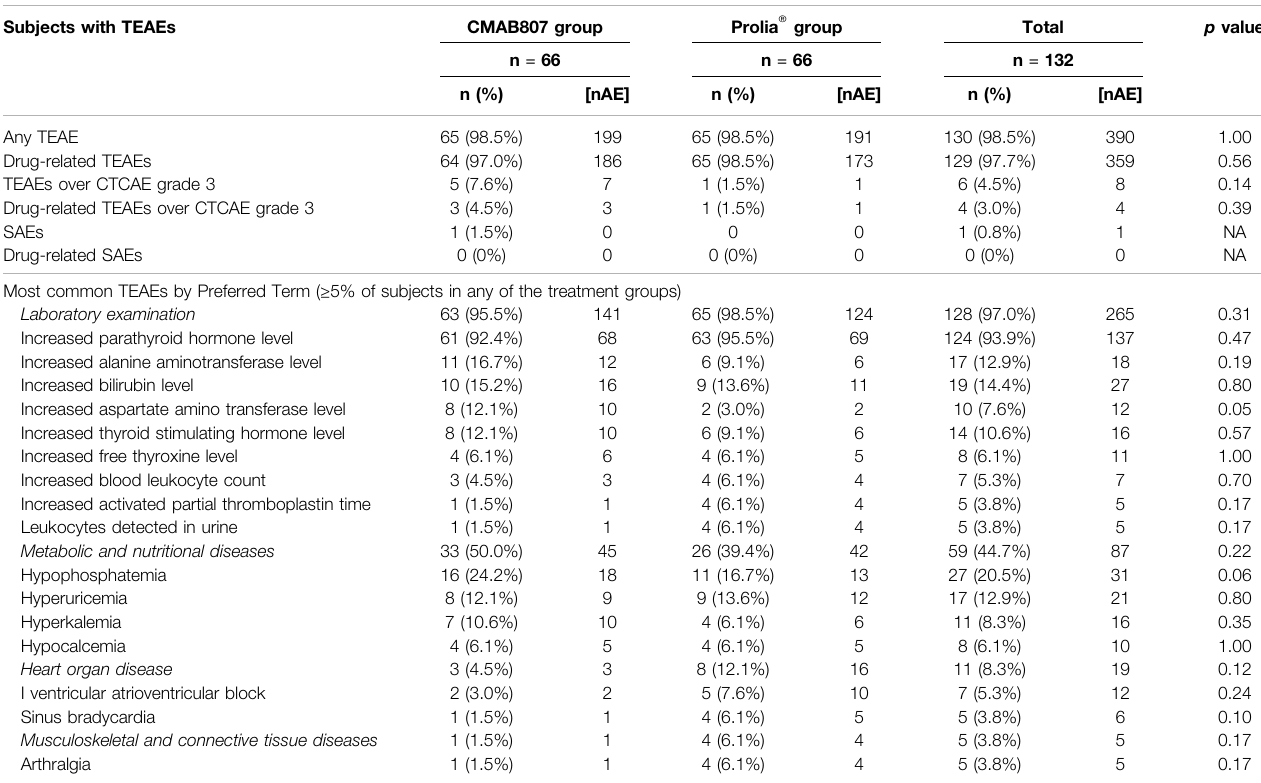
Frontiers in Pharmacology |